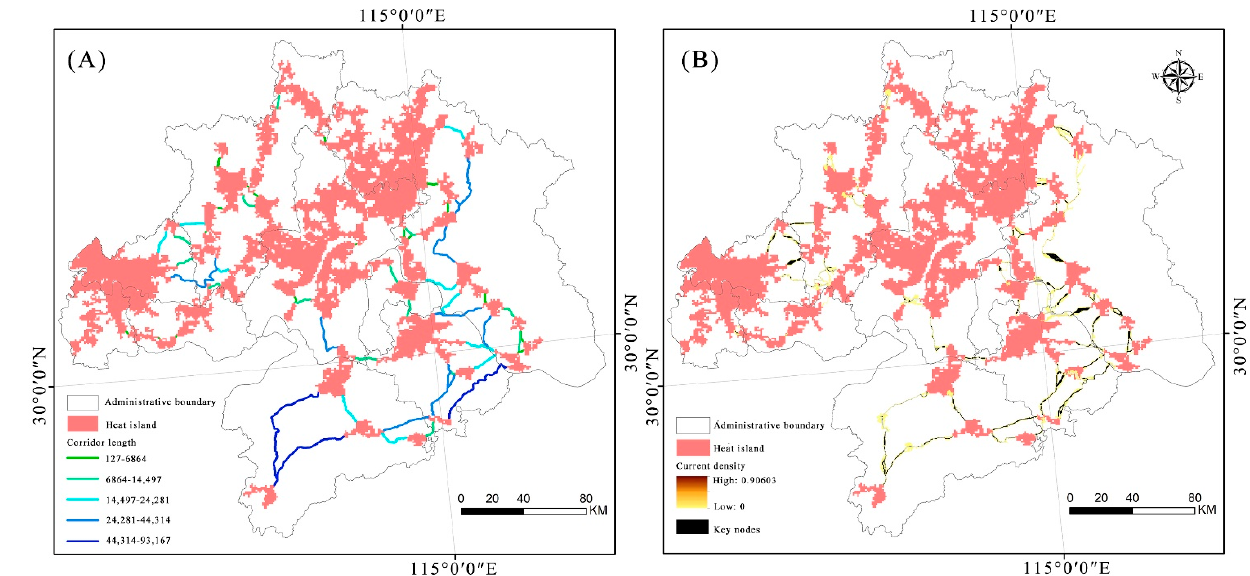
Figure 7. Locations of the heat island network ( A ) and key nodes ( B ) in the study area.